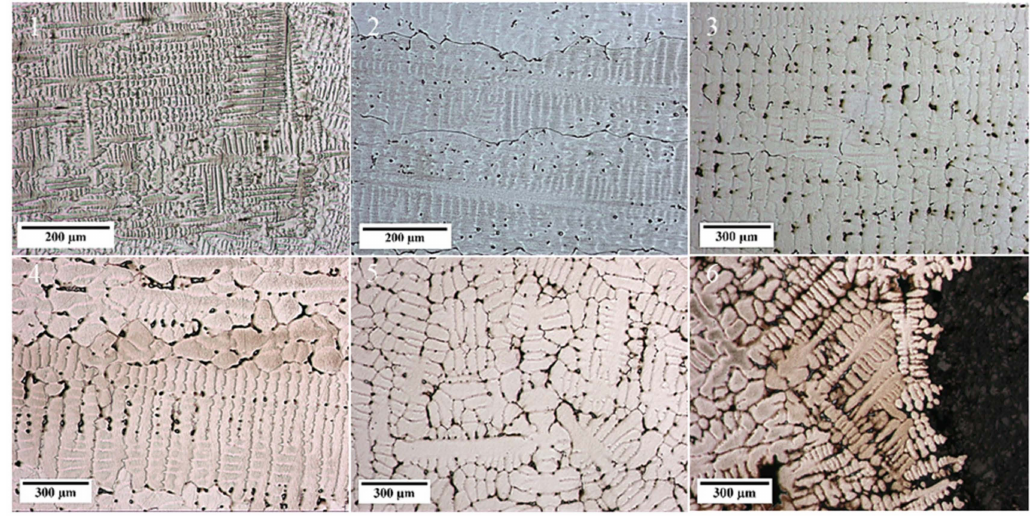
Figure 4. LOM images showing dendrite structure in etched samples from the surface to the center of the billet, at the distances; ( 1 ) 5 mm, ( 2 ) 15 mm, ( 3 ) 30 mm, ( 4 ) 45 mm, ( 5 ) 60 mm and ( 6 ) 70 mm.